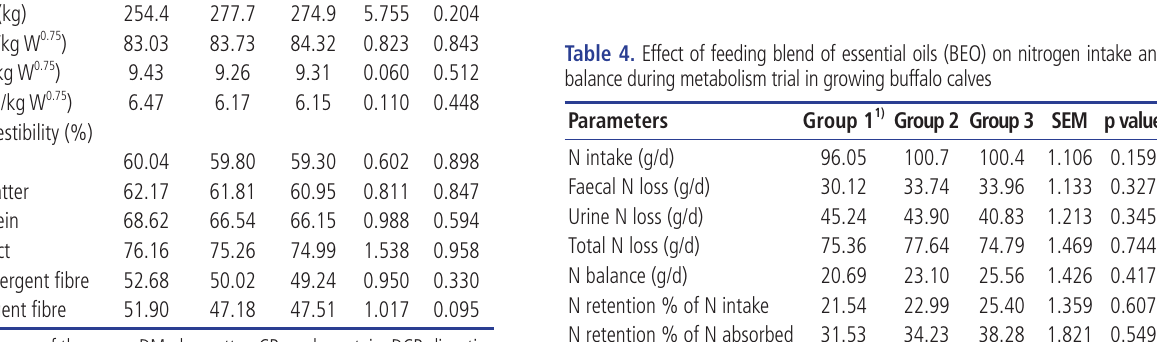
Table 3. Effect of feeding blend of essential oils (BEO) on plane of nutrition and apparentdigestibility of nutrients during metabolism trial in growing buffalo calves Parameters